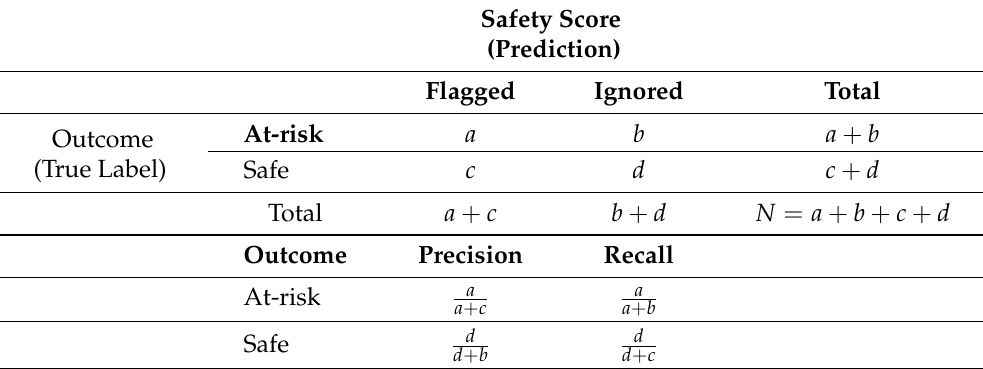
Table 10. Format of the Summary of